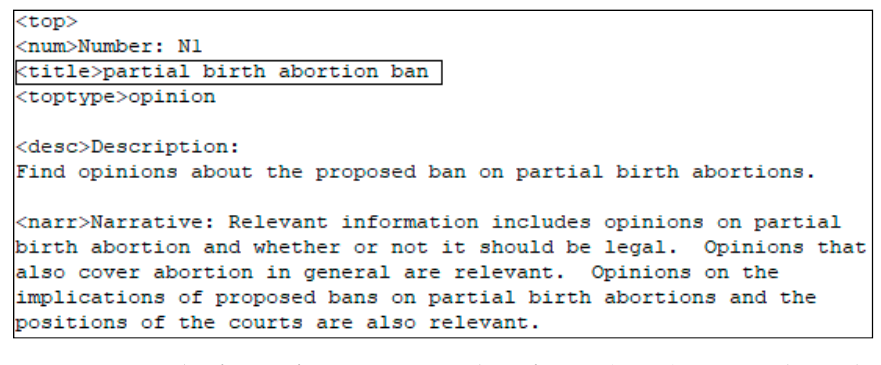
Figure 1. Example of query from Text Retrieval Conference (TREC) 2003 novelty track.